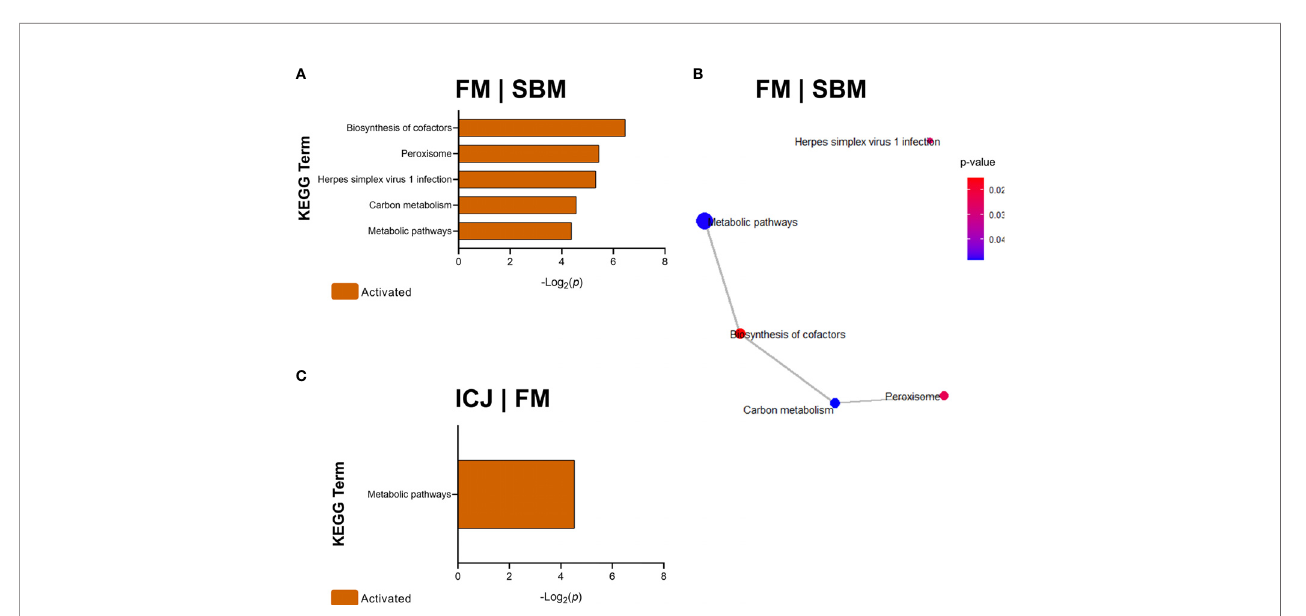
FIGURE 4 | KEGG Pathway Enrichment Analysis of DEGs (minGSSize = 3) from spleen in fi sh fed FM compared to SBM (FM|SBM) and ICJ compared to FM (ICJ| FM). List ordered by -Log 2 ( p ). (A) Signi fi cant KEGG terms in FM compared to SBM. (B) KEGG network analysis between FM and SBM. (C) Signi fi cant KEGG terms in ICJ compared to